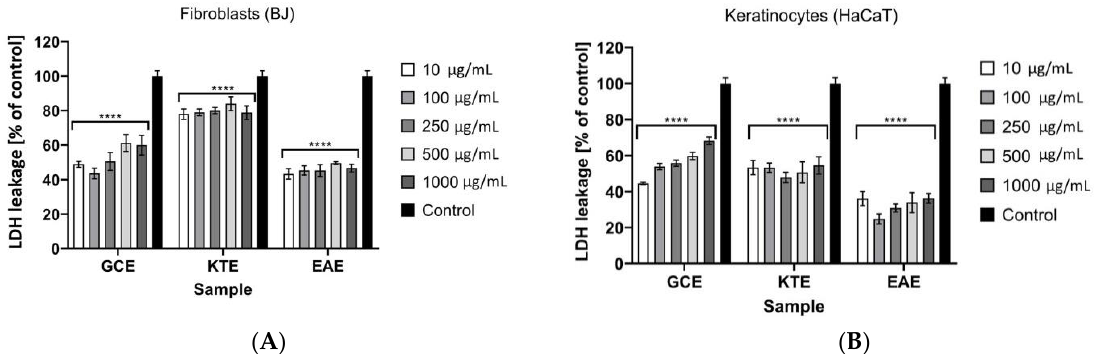
Figure 13. The release of LDH after 24h exposure to Centella asiatica L. ( GCE ), Clitoria ternatea L. ( KTE ) and Epilobium angustifolium L. (EAE) extracts in cultured ( A ) fibroblasts (BJ) and ( B ) keratinocytes (HaCaT). Data are the mean ± SD of three independent experiments, each of which consists of three replicates per treatment group. **** p < 0.0001 versus the control (100%).